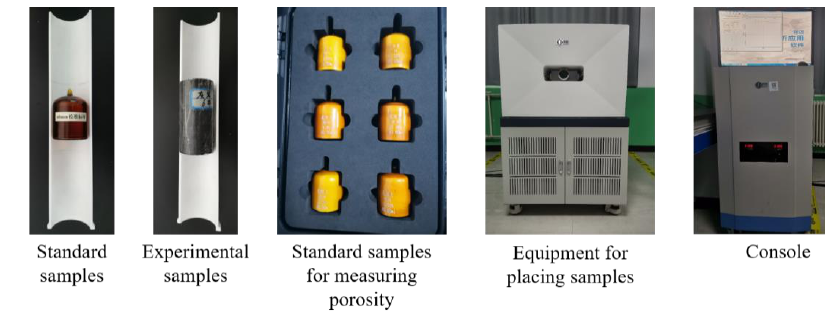
Figure 6. Porosity test.